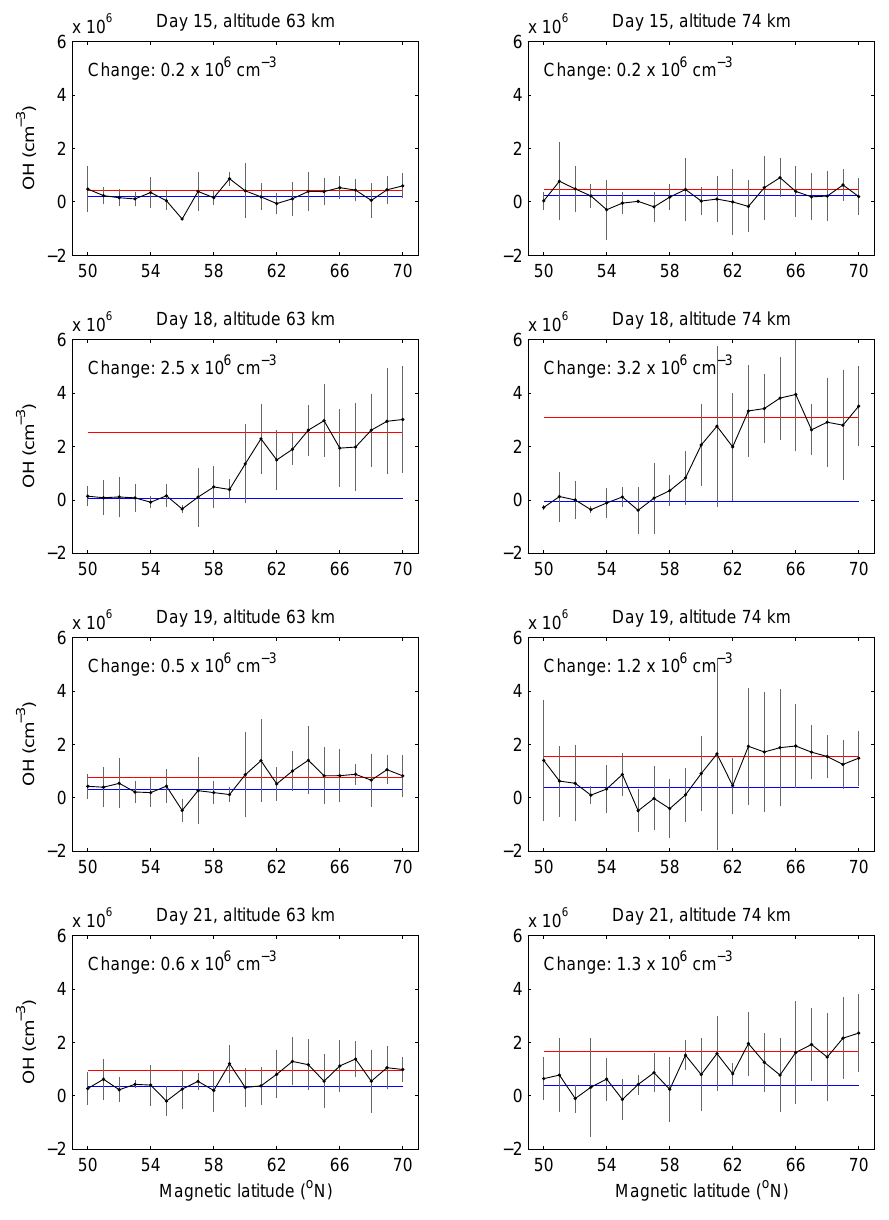
Fig. 4. Night-time OH concentrations at 63 and 74km for selected days of January. The data has been averaged to 1 ◦ -wide latitude bins at 00:00–06:00UT for each day (black dots). The local time of the observations ranges between 02:30 and 03:00. Standard deviations are shown with vertical gray lines. The blue and red lines indicate average values at 50–55 ◦ N and 65–70 ◦ N, respectively, representing approximately the concentrations not affected and strongly affected by